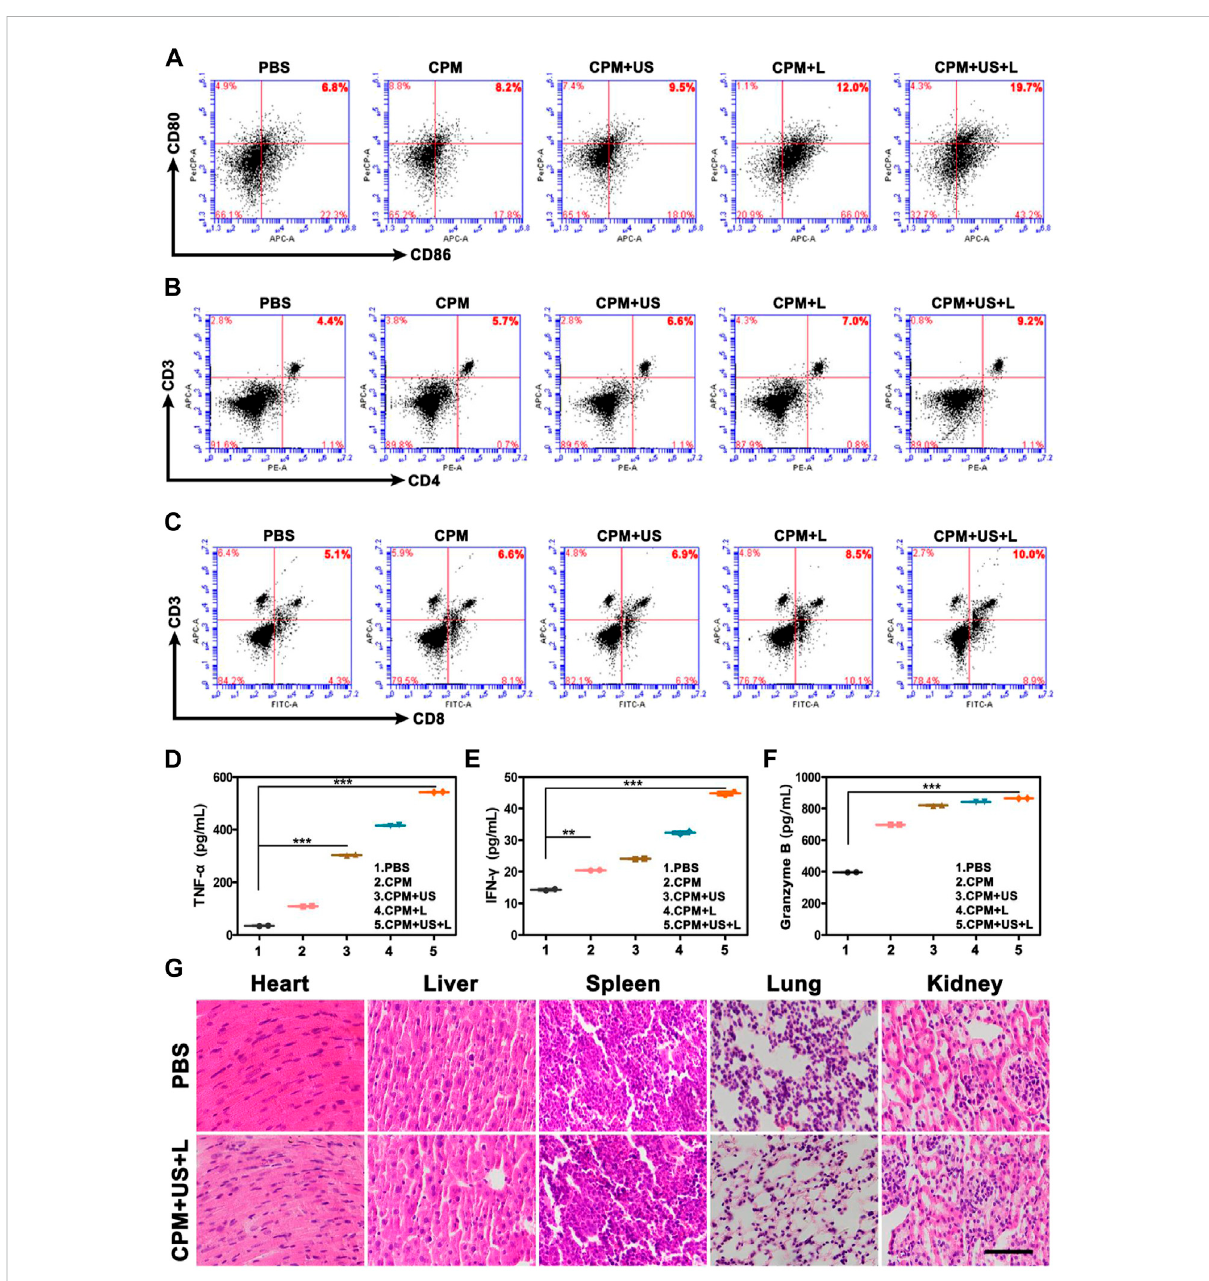
FIGURE 7 Representative fl ow cytometry pro fi les of (A) CD80 + /CD86 + DC cells after indicated procedures in the lymph nodes, (B) CD3 + /CD4 + T cells in the spleen and (C) CD3 + /CD8 + T cells in the spleen. (D – F) The ELISA analysis of intraserous cytokine levels of TNF- α , IFN- γ , and Granzyme B after different treatments on day 15. (G) H and E-stained images of major organs of BALB/c mice in various groups. (Scale bar: 100 μ